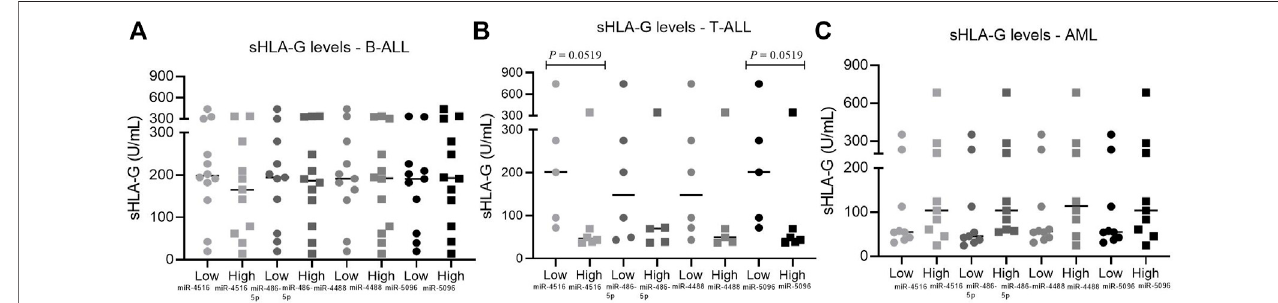
FIGURE 8 | Relationship between sHLA-G with miRNAs expression in leukemic bone marrow. (A) Relationship between sHLA-G and miRNAs expression in B-ALL: low miR-4516, n = 12; high miR-4516, n = 11; low miR-486-5p, n = 11, high miR-486-5p, n = 12; low miR-4488, n = 11, high miR-4488, n = 12; low miR-5096, n = 11, high miR-5096, n = 12; (B) relationship between sHLA-G and miRNAs expression in T-ALL: low miR-4516, n = 5, high miR-4516, n = 6; low miR-486-5p, n = 6, high miR-486-5p, n = 5; low miR-4488, n = 6, high miR-4488, n = 5; low miR-5096, n = 5, high miR-5096, n = 6; (C) relationship between sHLA-G and miRNAs expression in AML: low miR-4516, n = 9, high miR-4516, n = 9; low miR-486-5p, n = 9, high miR-486-5p, n = 9; low miR-4488, n = 10, high miR-4488, n = 8; low miR- 5096, n = 9, high miR-5096, n = 9. For comparison of two groups, the Mann – Whitney test was